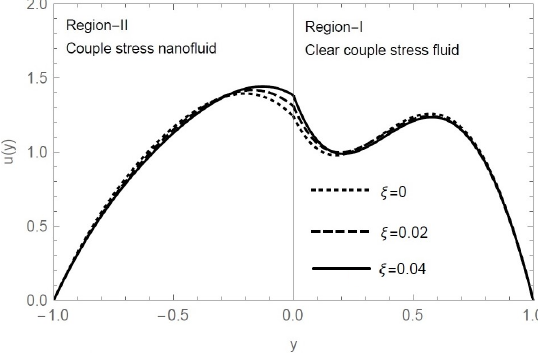
Figure 7: The influence of couple stress parameters ξ i on velocity profiles using λ 1 = 50, h = 1, Γ i = δ i = 0.1, N b = N t = 0.1, Pr i = 3 and µ = K = .0.5 .